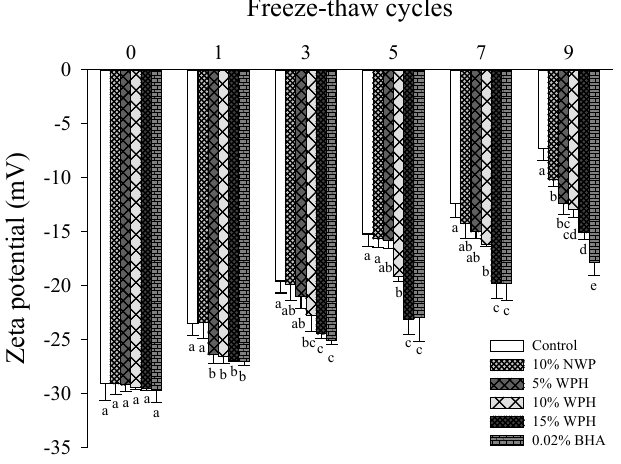
Figure 4. Changes in the zeta potential of myofibrillar protein (MP) of multiple freeze–thaw (F–T) cycles of pork patties with different whey protein hydrolysate (WPH) contents. The significant differences among different samples are indicated by different lowercase letters (a–e). Control: without any additives in the sample; NWP: native whey protein; BHA: butylated hydroxyanisole.